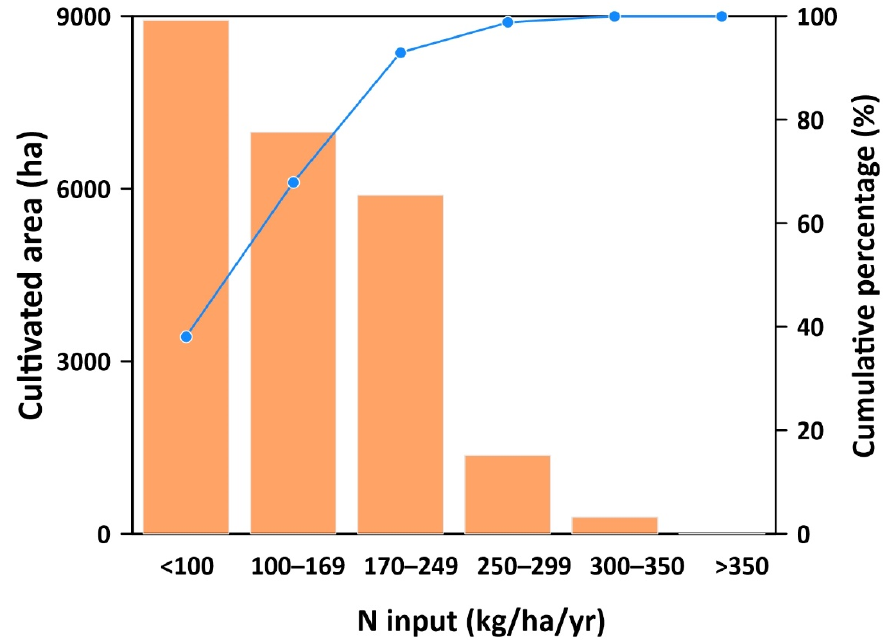
Figure 6. Histogram showing total cultivated area for different intervals of N input (orange bar) and its cumulative percentage (blue line).